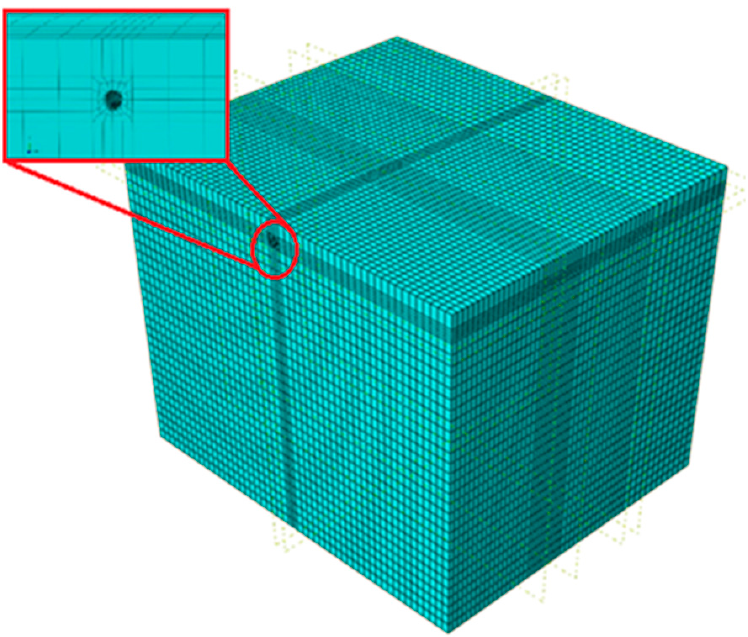
Figure 5. Finite element model for the tunnel soil in ABAQUS . Table 4. Material properties and unit